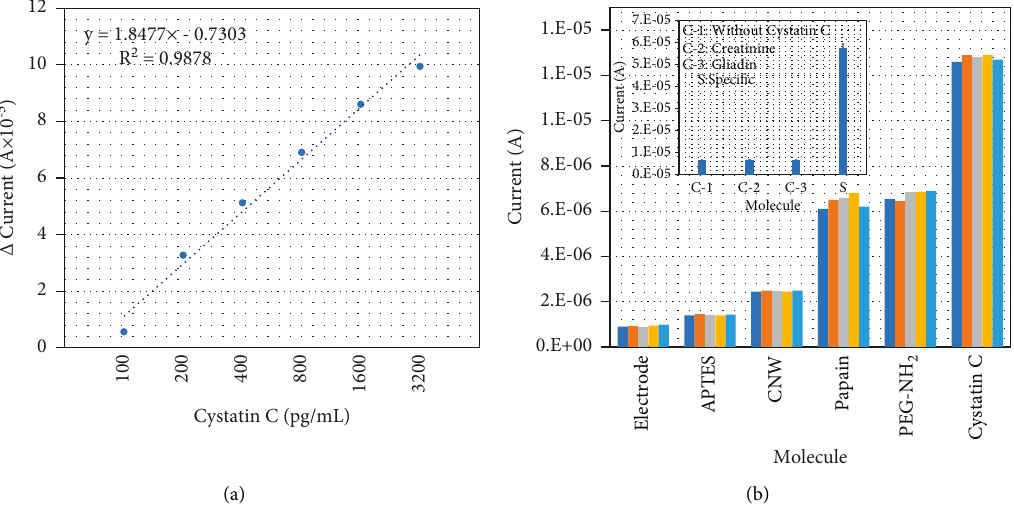
Figure 5: (a) Differences in current response (from blank) for different concentrations of Cystatin C were plotted in an excel sheet, and the limit of Cystatin C detection was calculated in the range between 100 and 200pg/mL with the R 2 value of 0.9878. (b) Reproducibility analysis of Cystatin C identification. There are no significant changes in the current response of the bare electrode, APTES, CNW, papain, PEG-NH 2 , and Cystatin C with five different electrodes, which confirms the reproducibility of the papain-modified electrode. The figure inset displays the specificity analysis of Cystatin C control experiments with creatinine and gliadin (instead of Cystatin C) conducted to identify the specific detection of Cystatin C on the papain-modified electrode surface. Without Cystatin C and with control protein, no significant changes of current response were noted. Cystatin C was specifically recognised by the immobilized